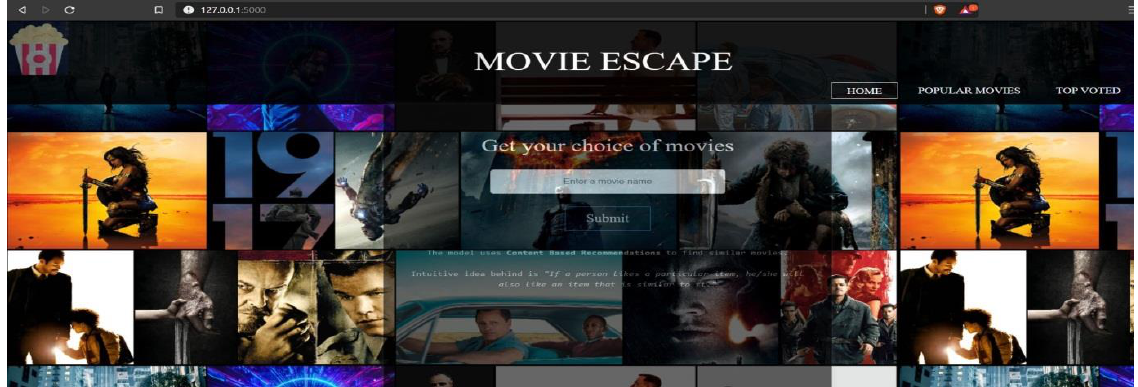
Figure 1. Our proposed movie recommendation system website home